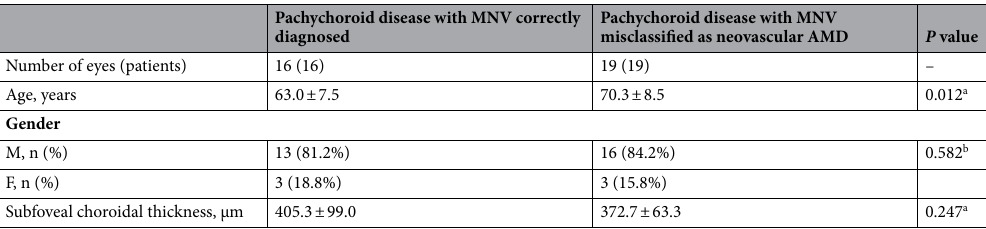
Table 2. Characteristics of patients with pachychoroid neovasculopathy. Quantitative values are expressed in mean ± SD (standard deviation). a T-test. b Fischer’s exact test.